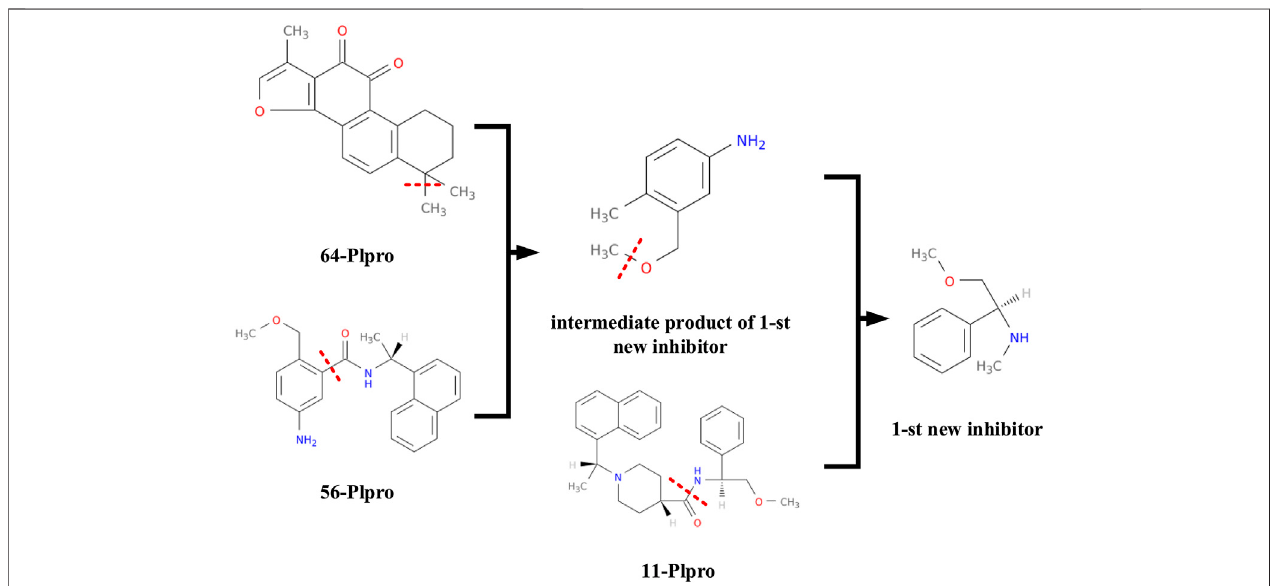
FIGURE 9 | The fi rst inhibitor ’ s synthetic